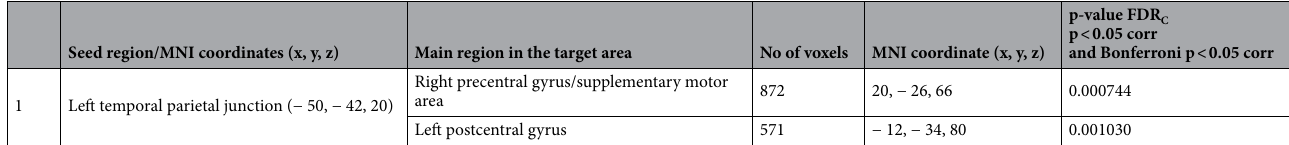
Table 2. Resting-state functional connectivity found correlated positively with the temporal order threshold (TOT) values after controlling for the influence of G f , TOT × G f interaction and gender in all participants (n = 65). The Montreal Neurological Institute (MNI) coordinates for the center position of the seed are placed in the bracket, right after the seed’s name, whereas the MNI coordinates of the peak voxel of each target region are in a separate column. The relationships were significant (mass p-value FDR C , p < 0.05) with Bonferroni correction for multiple comparisons (p <